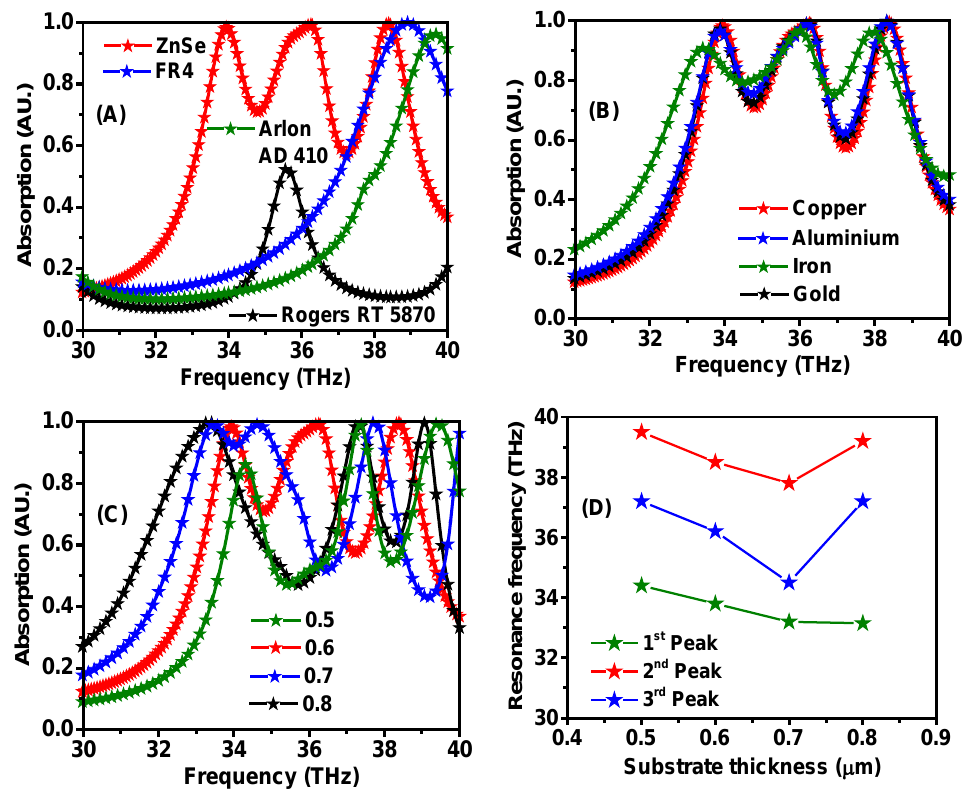
Figure 5. ( A ) Parametric study for different substrate materials, ( B ) various resonator materials, ( C ) change of the thickness of the substrate, and ( D ) substrate thickness dependence of the resonance frequency shift.